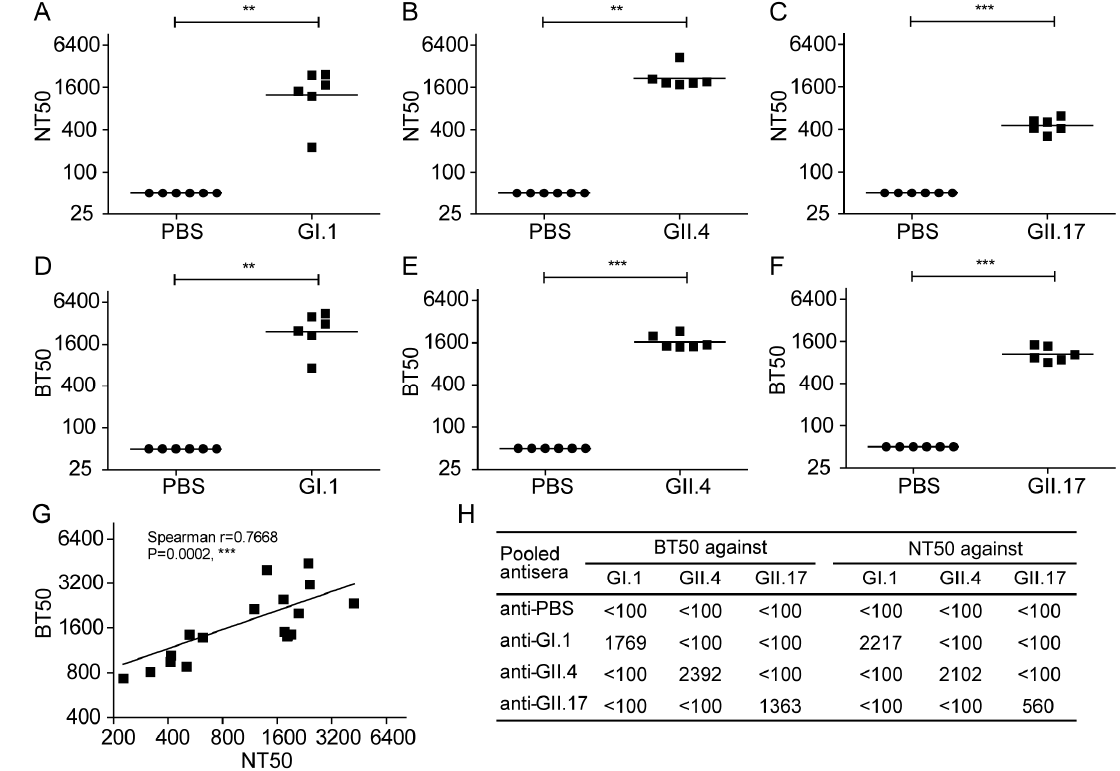
Figure 6. Evaluation of norovirus vaccines by a cellular ELISA-based attachment inhibition assay. Four groups of mice were immunized intraperitoneally with GI.1 virus-like particles (VLPs), GII.4 VLPs, GII.17 VLPs, or PBS, respectively, at weeks 0 and 2. Sera were collected from all immunized mice at 2 weeks after the last immunization and subjected to attachment inhibition assay and histo-blood group antigen blocking assay. ( A ) The 50% neutralization titers (NT50s) and ( D ) 50% blocking titers (BT50s) of sera from the GI.1 VLP group against GI.1; ( B ) NT50s; and, ( E ) BT50s of sera from the GII.4 VLP group against GII.4; ( C ) NT50s; and, ( F ) BT50s of sera from the GII.17 VLP group against GII.17. Samples that showed less than 50% blockade or inhibition at a 1:100 dilution (the lowest dilution tested) were assigned a titer of 50 for geometric mean titer computation. Each symbol represents one mouse, and the line indicates the geometric mean value of the group. Statistical significance was determined by the Student’s t- test using GraphPad Prism version 5, and values are indicated as follows: ** p < 0.01; *** p < 0.001; ( G ) Spearman’s correlation between NT50s and BT50s. Each square represents one mouse. Spearman’s r and p values are shown; ( H ) Potential neutralization of the pooled antisera against GI.1, GII.4 and GII.17. The lowest dilution tested is 1:100. All of the experiments were replicated three times.